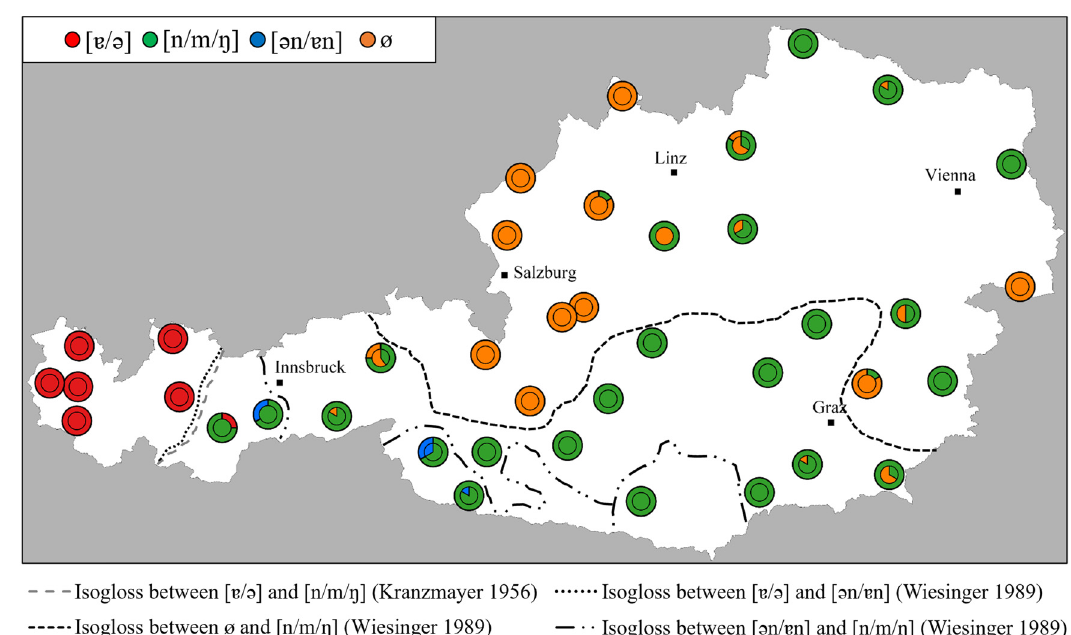
Figure 7: ( en ) following vowels/glides ( inner circles = percentage of variants realised by older speakers; outer circles = percentage of variants realised by younger speakers )